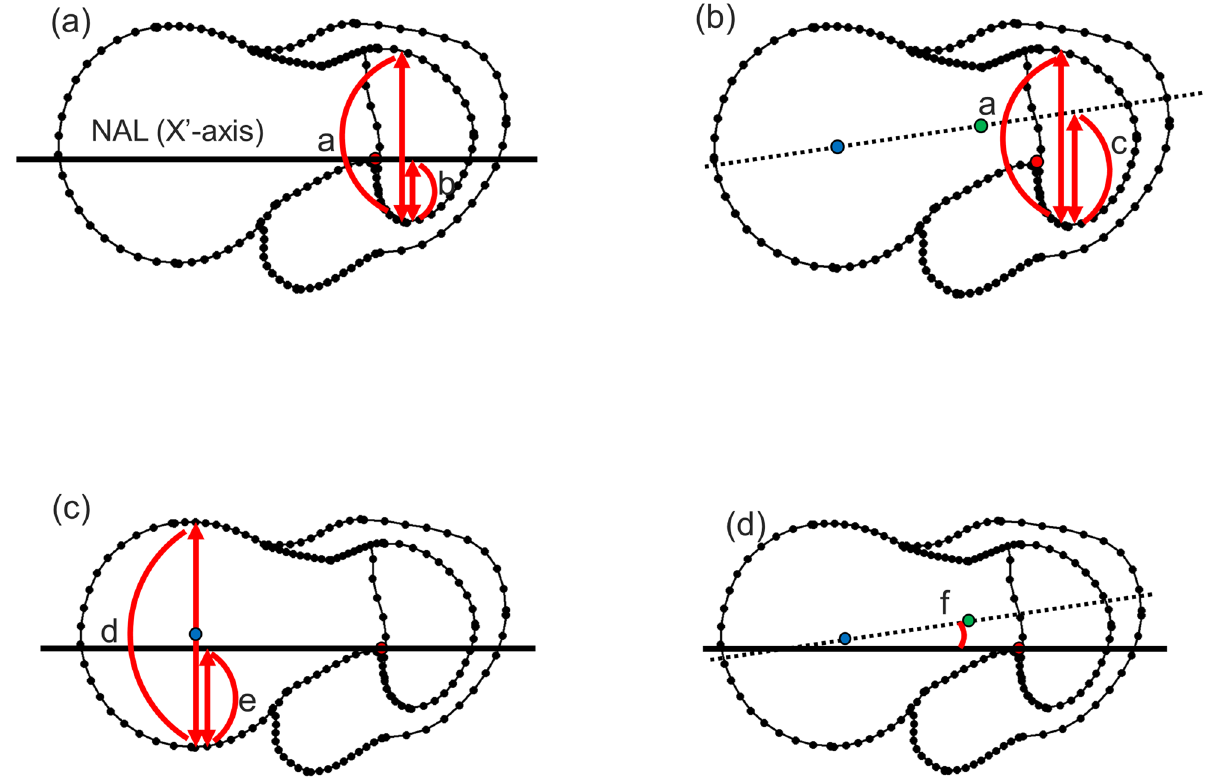
Figure 4. ( a ) Insertion point to the canal at the greater trochanter: NIP. NAL shows the native anteversion line (NAL), which passes the z-axis; the red point, the extension line of the centre of the femoral canal (Z-axis); a, the length from the posterior to the anterior edge of the greater trochanter; b, the length from the posterior edge to the passing point of the NAL. ( b ) Intersection point of the head-neck axis and greater trochanter: LSR. The blue point shows the femoral head centre; the green point, the neck centre at the narrowest point of the neck; c, the length from the posterior edge to the passing point of the line through the femoral head centre and the femoral neck centre (dotted line, line of head-neck) in this shape at the greater trochanter. ( c ) Passing point of the native anteversion at the femoral head: MDL. d shows the length of the femoral head diameter; and e, the length from the posteriormost point to the passing point of the NAL. ( d ) Angle between the native anteversion and head-neck axis: MAL. F shows the angle between the line of the head-neck centre (dotted line) and the native anteversion (solid